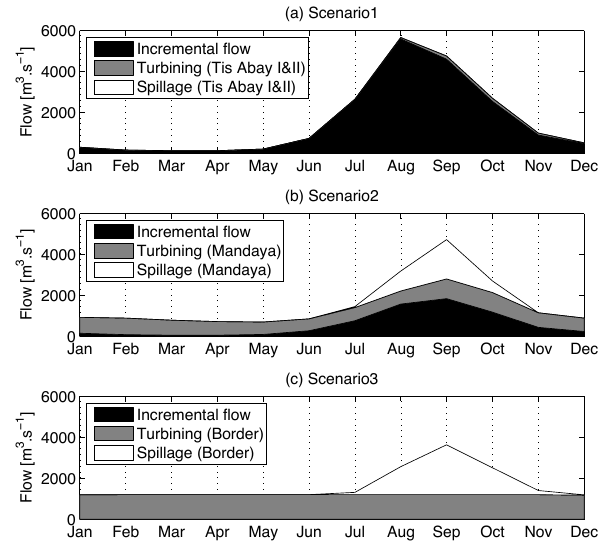
Fig. 8. Average monthly discharge downstream the cascade of Ethiopian reservoirs (Sudanese/Ethiopian border).